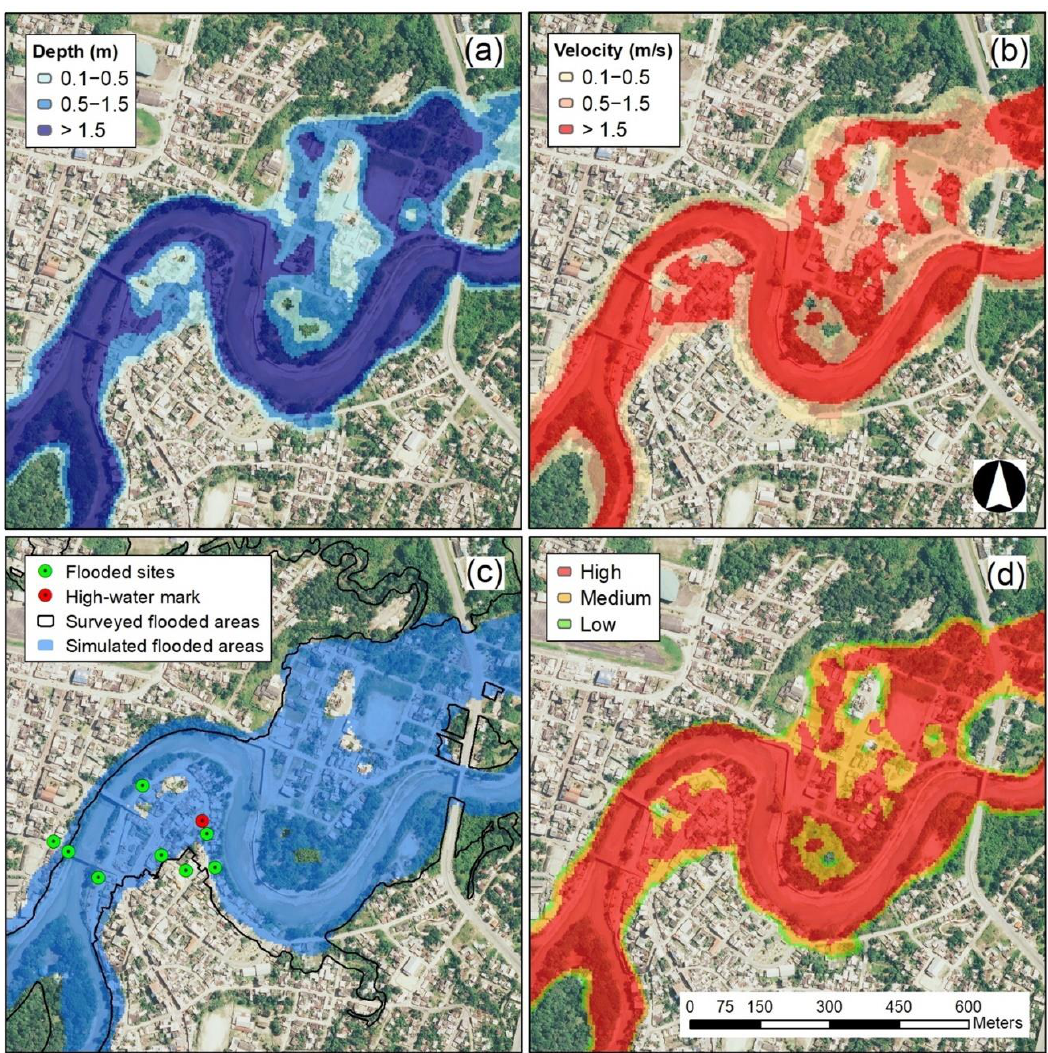
Figure 7. Reconstructed 500-year flood event. ( a ) water depths; ( b ) flow velocities; ( c ) simulated flood extent against surveyed flooded areas (black line) and control points of flooded sites (greenish dots), and location of the high-water mark (reddish dot); ( d ) flood intensity map as a function of flow velocity and water depth in compliance with Cançado et al. [75] guidelines (Table 3).